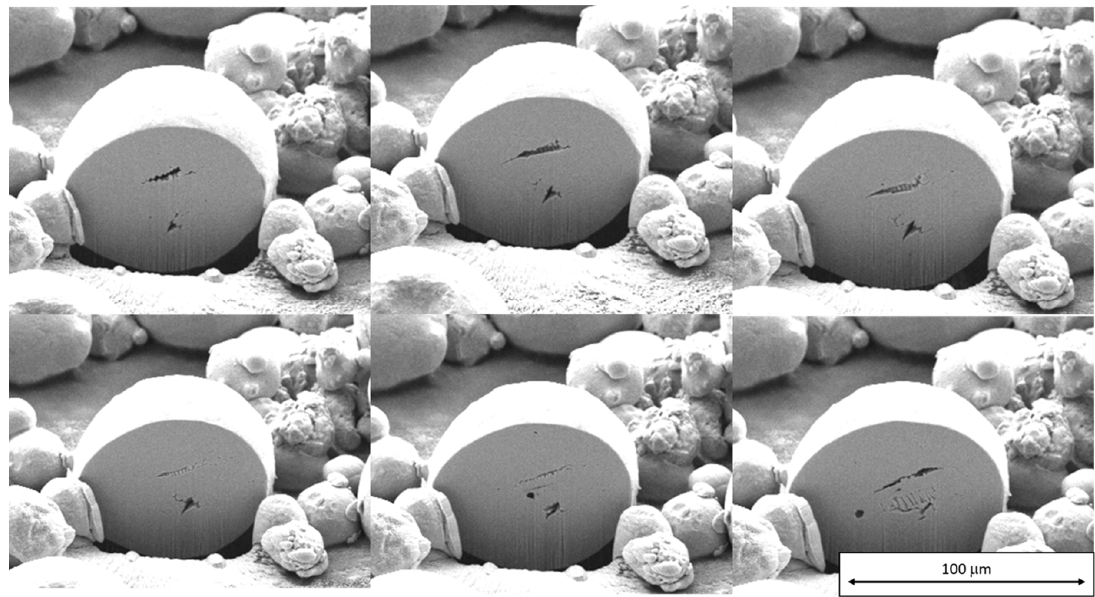
Figure 9. Scanning electron micrographs taken during FIB milling of a reused powder particle. Successive sections through defects in the particle can be seen. The shapes of these defects in the reused powder are not strictly spherical, in contrast to those in the virgin powder.